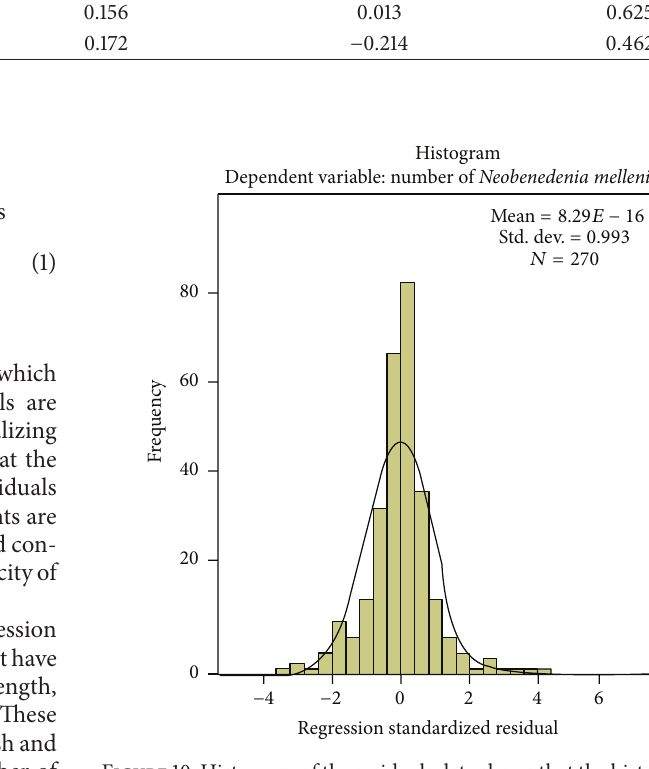
Figure 10: Histogram of the residuals data shows that the histogram has a bell shaped curve indicating that the residuals are normally